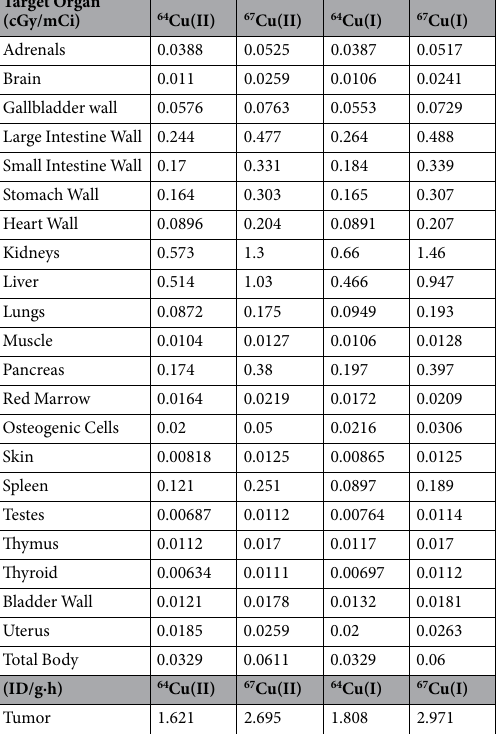
64 Cu(II) has been widely applied in radiolabeling small molecules, peptides, proteins, antibodies and nanopar-